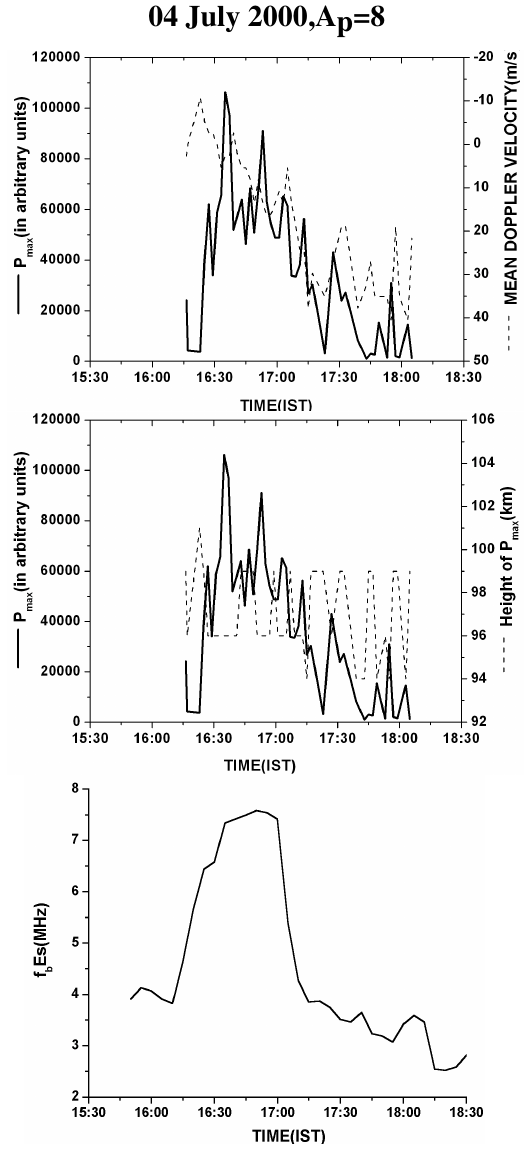
Fig. 10b. Same as Fig. 9b, but for 4 July